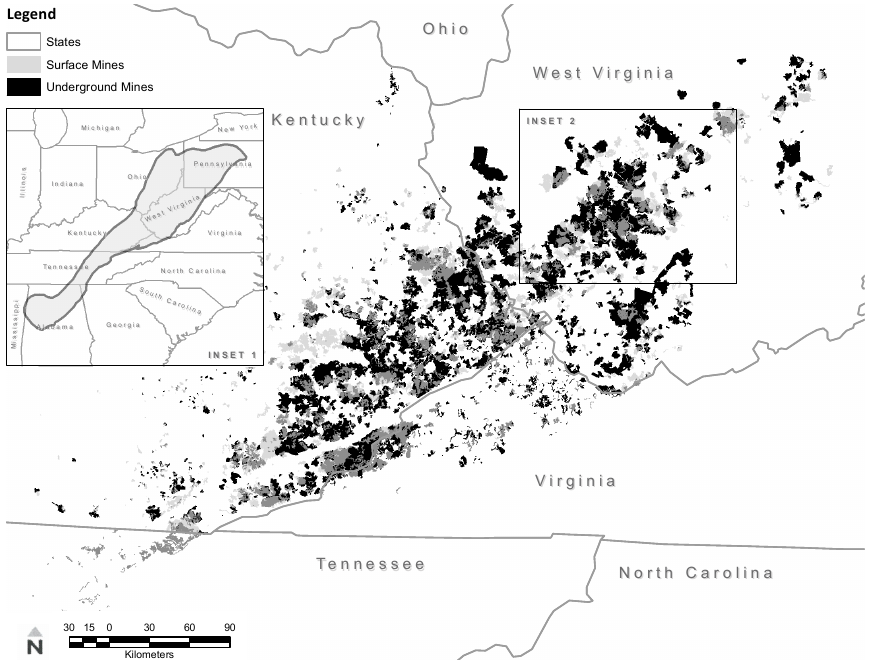
Figure 1. Extent of mountaintop removal mining and underground coal mining in the central Appalachian Mountains region. Surface mines have disturbed nearly 7% of this predominantly forested 4.86 million hectare region of West Virginia, Kentucky, Virginia and Tennessee, and underground mining has impacted 25% of the area. Inset 1: the Appalachian Coalfields region, extending from Pennsylvania to Alabama, has a long history of coal mining. Inset 2: location of the current